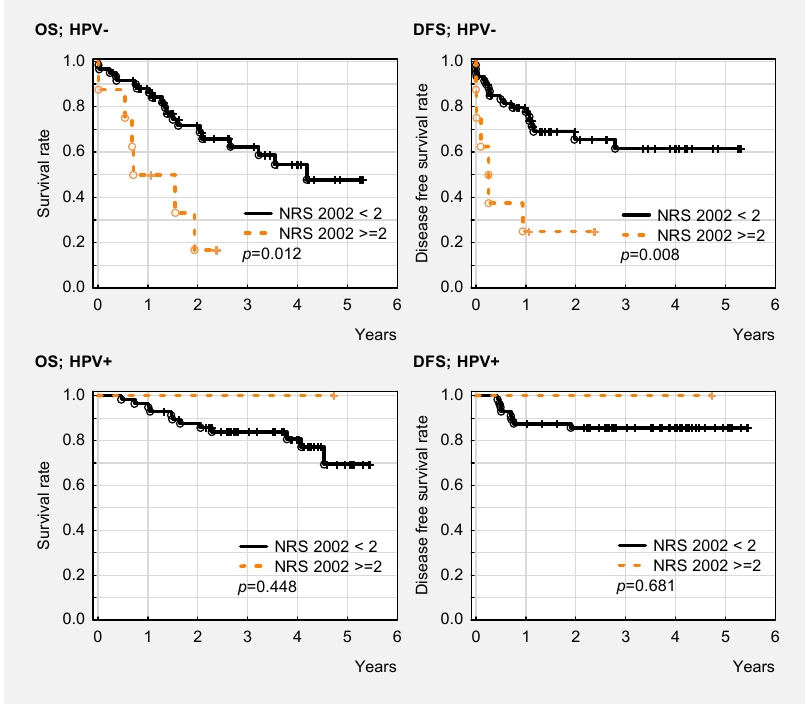
Figure 3. Overall and disease-free survival in HPV- and HPV+ patients according to NRS 2002 (NRS 2002 < 2 vs. NRS 2002 ≥ 2).